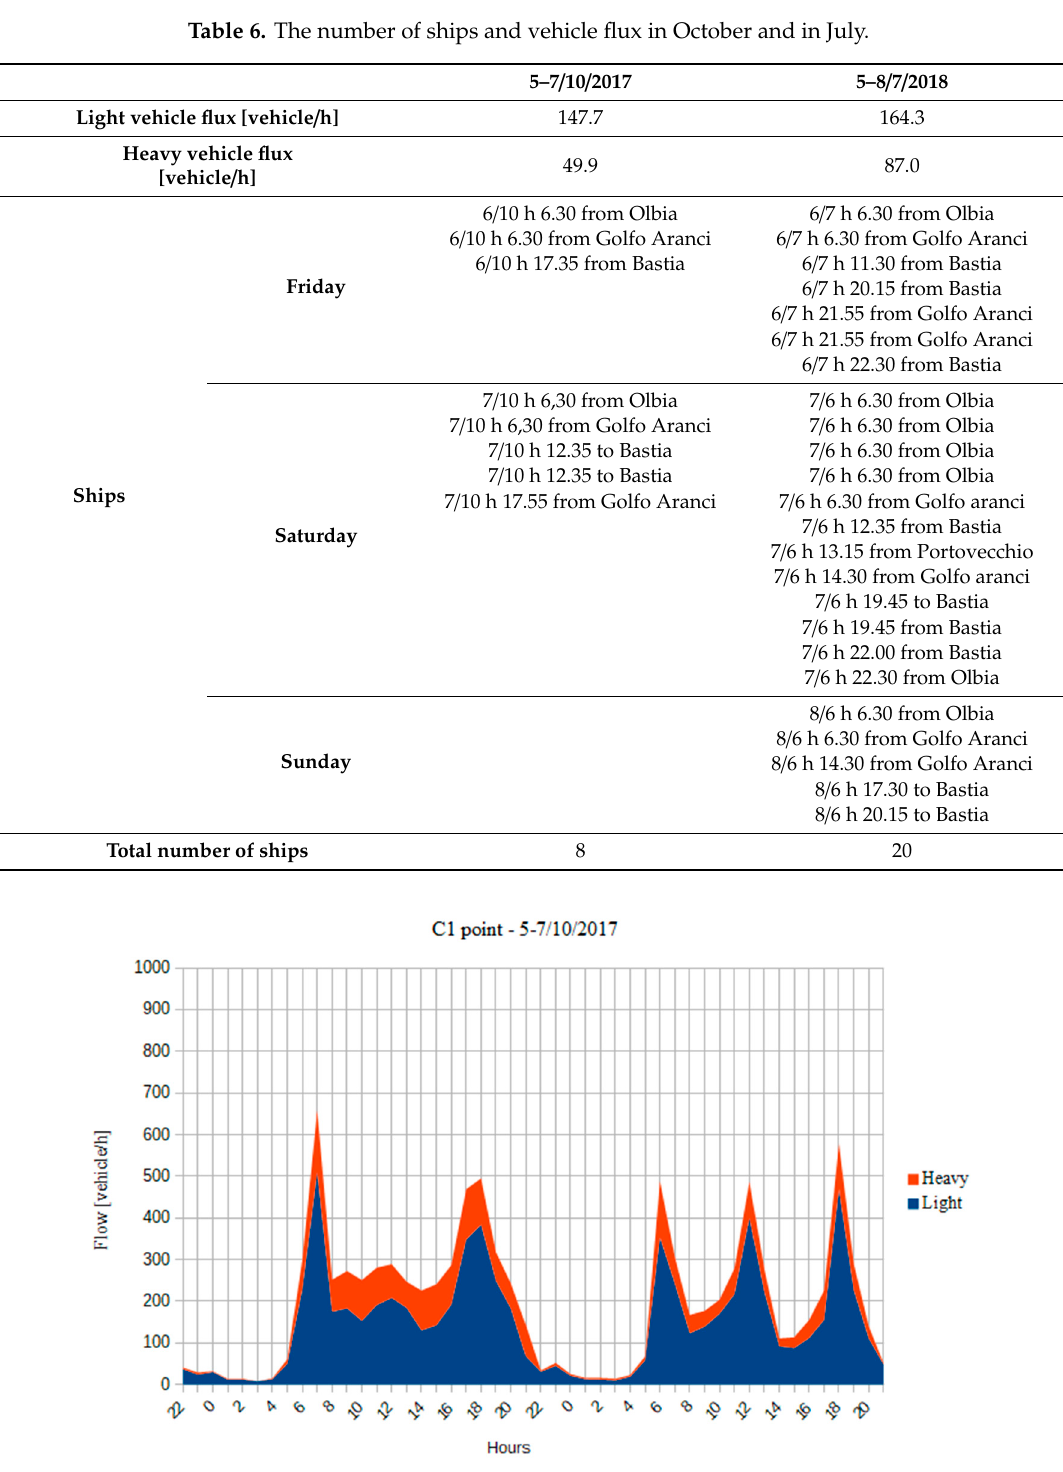
Table 6. The number of ships and vehicle flux in October and in July.